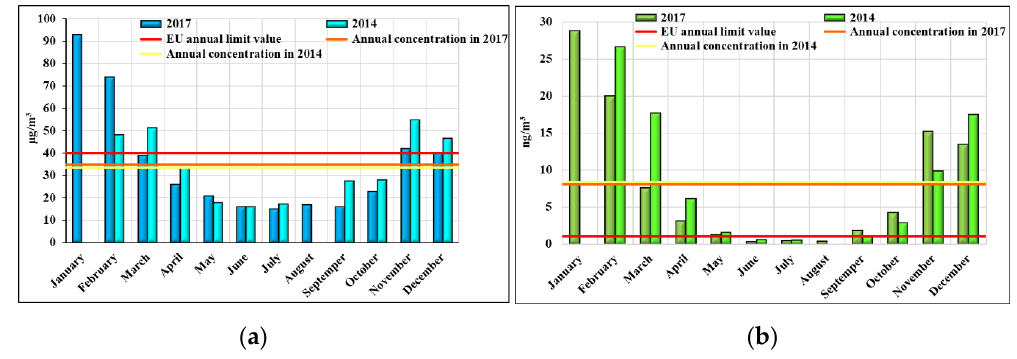
Figure 2. ( a ) Average annual and monthly concentrations of PM10; ( b ) Average annual and monthly concentrations of B(a)P [16].